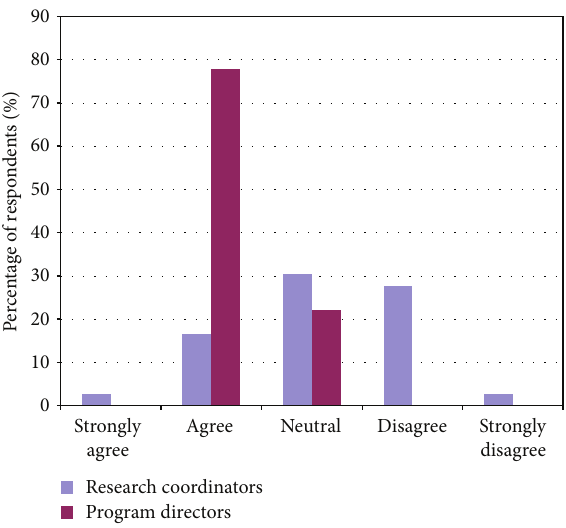
Figure 8: Comparing responses of program directors and research coordinators regarding trainees’ abilities in creating and managing a research